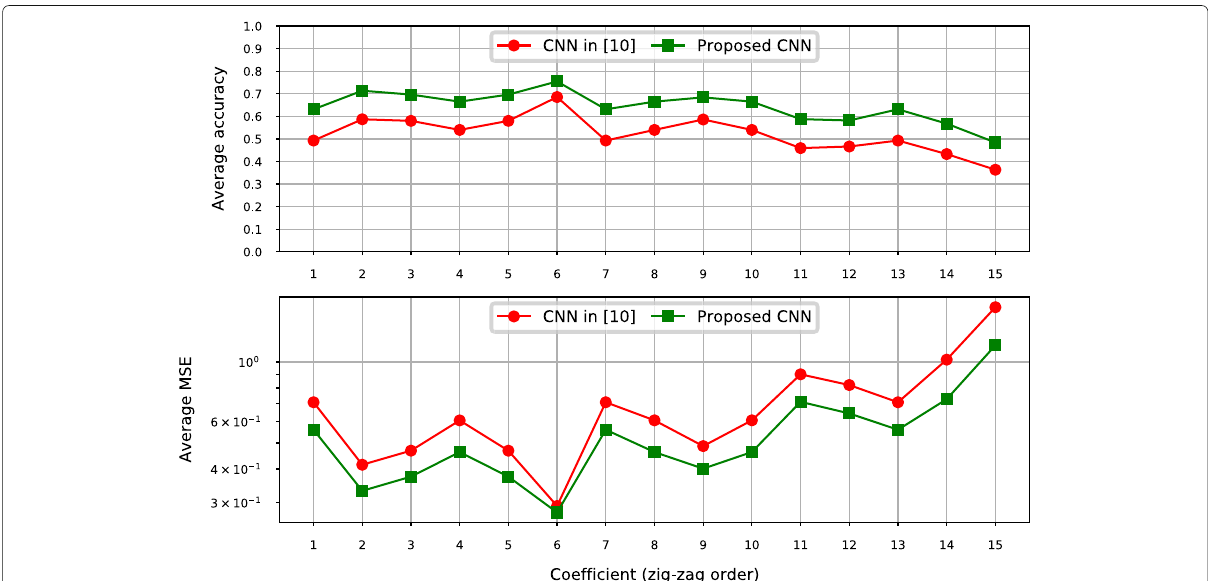
Fig. 9 Performance of the estimator on DJPEG images from a different database (Dresden), for QF 2 = 90. Average accuracy (top) and MSE (bottom) of the estimation for each of the 15 DCT coefficients